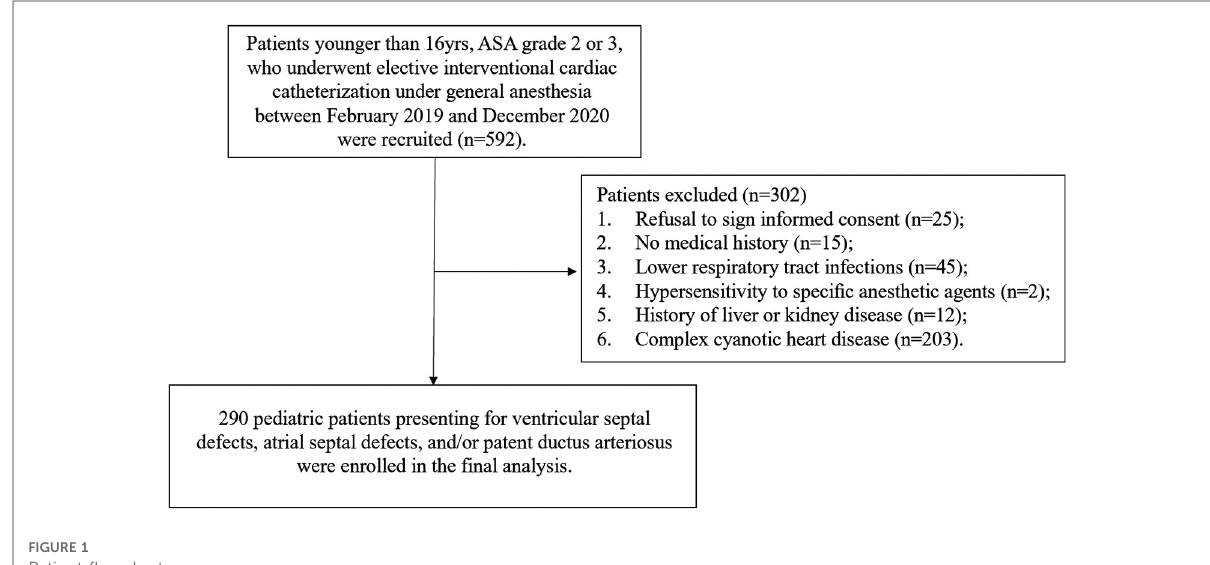
FIGURE 1 Patient fl